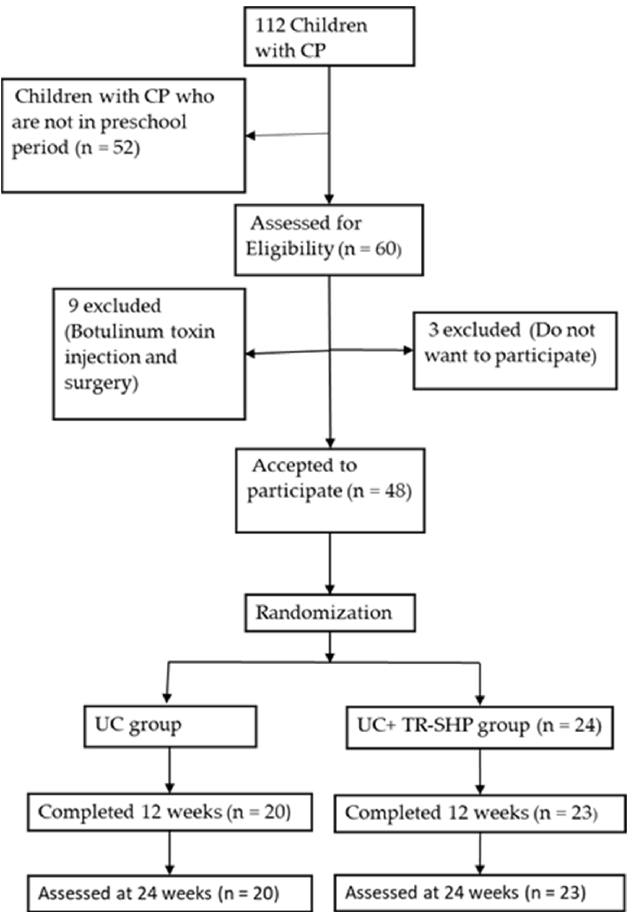
Figure 1. CONSORT flow diagram of patient recruitment and participation throughout the study. The inclusion criteria were (1) age between 3 and 6 years, (2) receiving two sessions of usual care service per week and (3) having family members actively using mobile phones, computers and the internet. The exclusion criteria were (1) any orthopedic surgery related to the lower or upper extremities in the last 6 months, (2) botulinum toxin injection to the upper or lower extremity muscles in the last 6 months and (3) uncontrollable epileptic